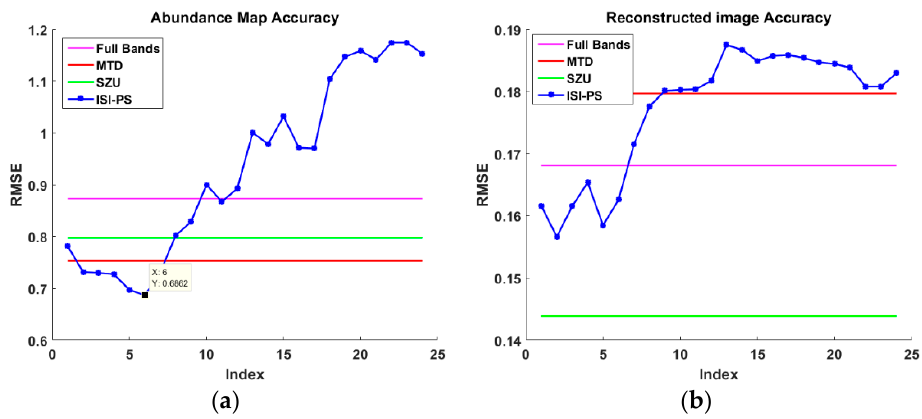
Figure 16. The RMSE of estimating: ( a ) The fractions; ( b ) The LTRAS image by means of the selected bands using the MTD, the SZU, and the ISI-PS algorithms for different threshold values.